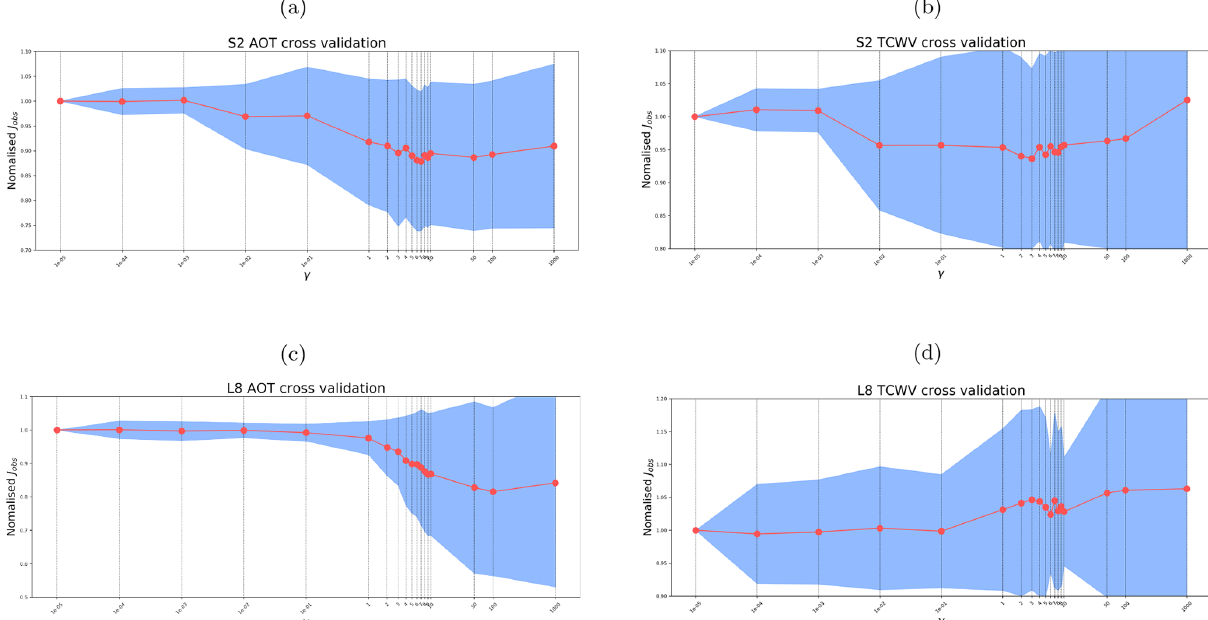
Figure G1. γ cross validation for (a) S2 AOT, (b) S2 TCWV, (c) L8 AOT, and (d) L8 TCWV. The x axis in the subplots is γ values ranging from 1 × 10 − 5 (essentially, no smoothness constraint) to 1000 (very high smoothness). The y axis shows J obs normalised by the J obs with a smallest γ value of 1 × 10 − 5 . The red dots show mean normalised J obs over a set of 20 S2 and L8 tiles. The blue fill shows ± 1 standard deviation of normalised J obs over the 20